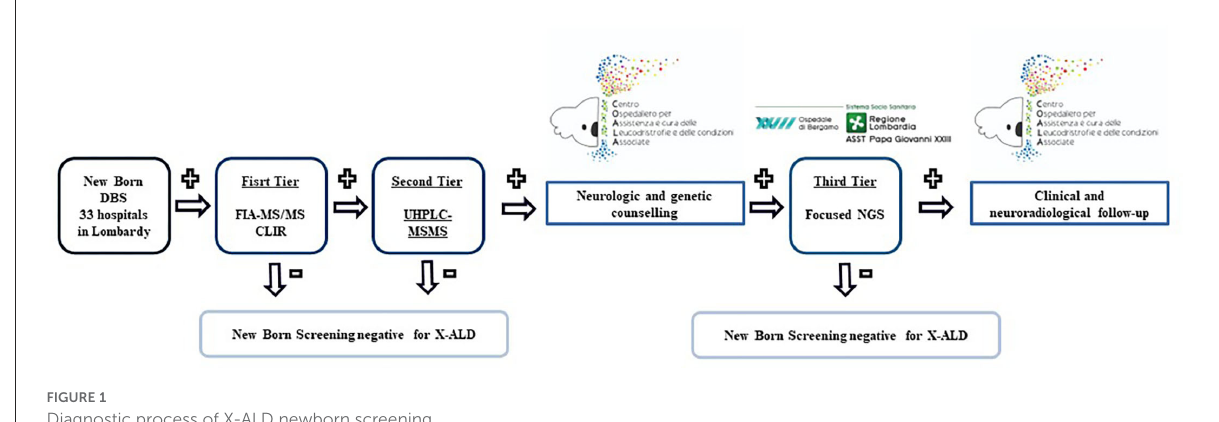
FIGURE1 Diagnostic process of X-ALD newborn